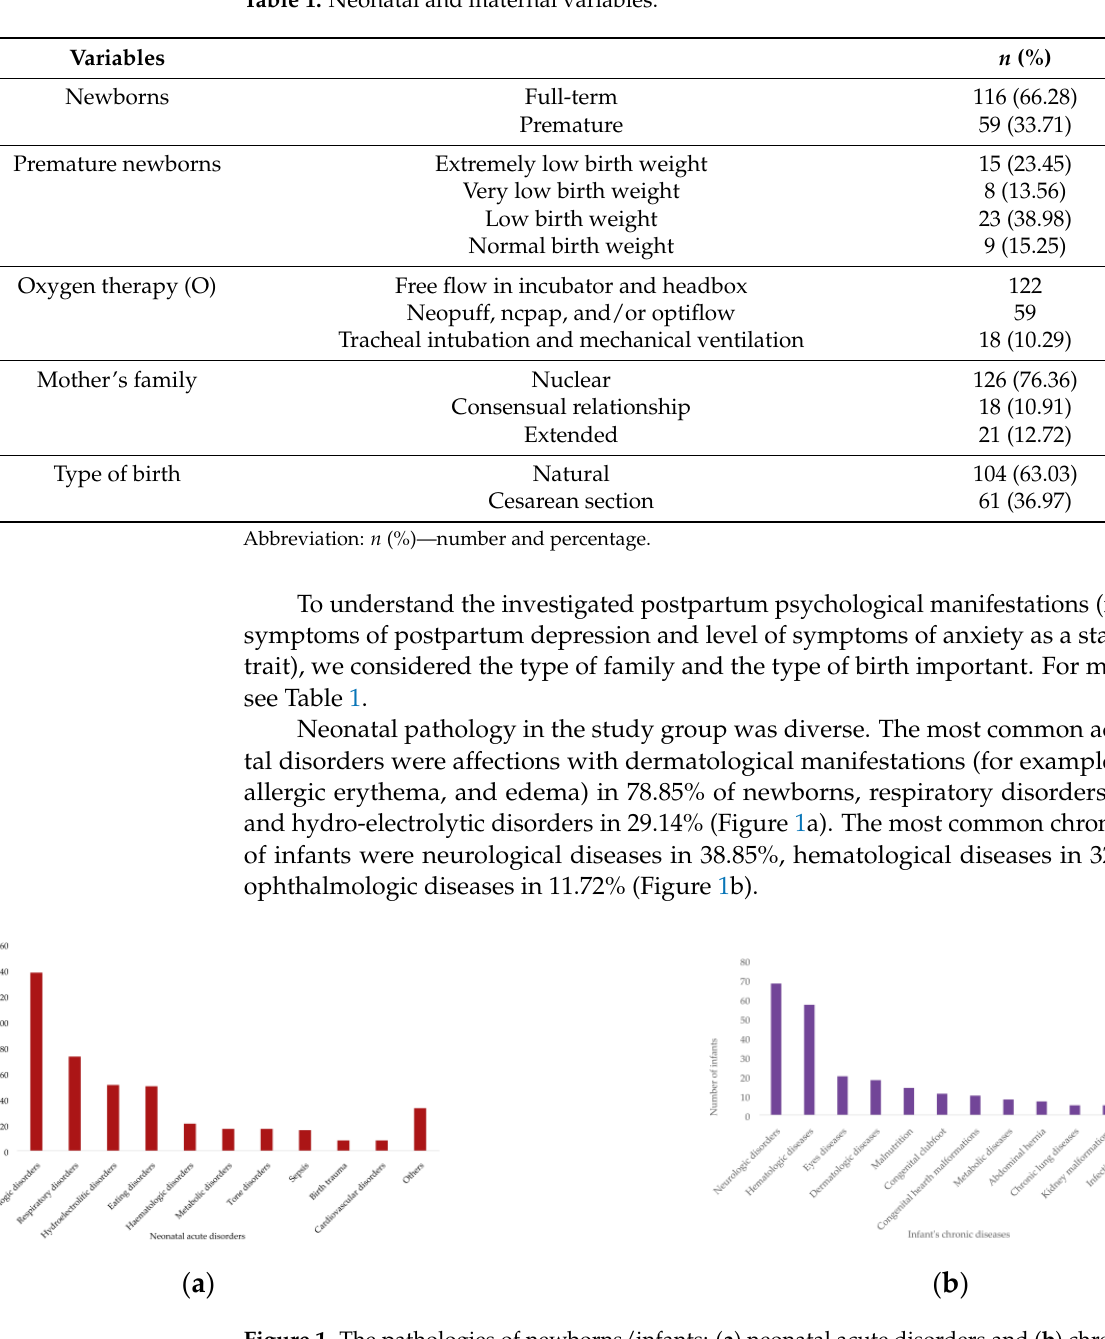
Figure 1. The pathologies of newborns/infants: ( a ) neonatal acute disorders and ( b ) chronic diseases of infants.